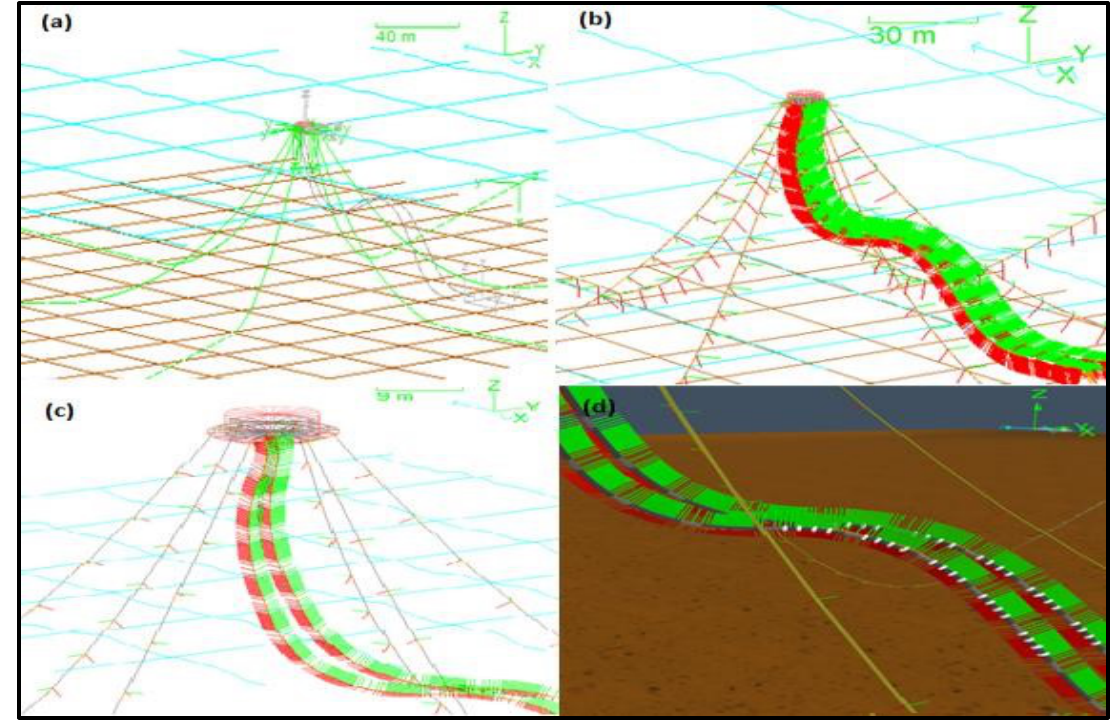
Figure 11. CALM Buoy system finite element model showing Orcaflex details of ( a ) FEM wireframe view ( b ) nodal axes ( c ) buoy and mooring line nodes ( d ) submarine hoses with floats .